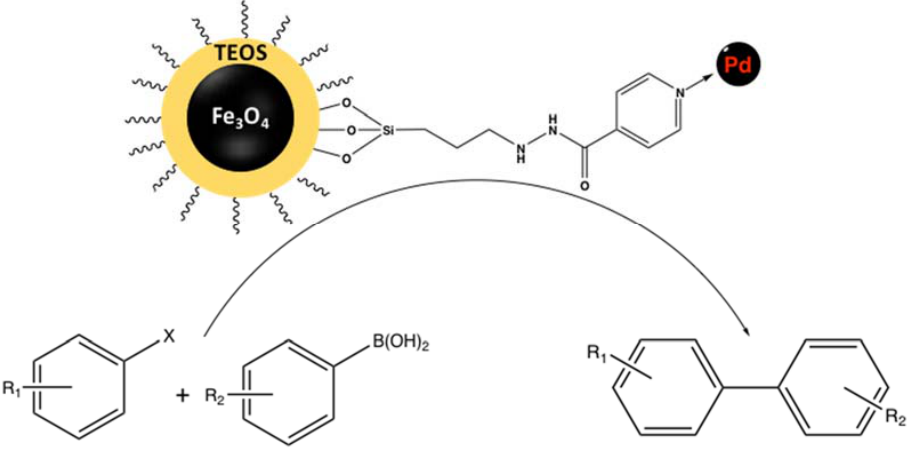
Figure 12. Fe 3 O 4 @SiO 2 /isoniazide/Pd mediated Suzuki cross ‐ coupling reaction [67] (Adapted with permission from Elsevier).